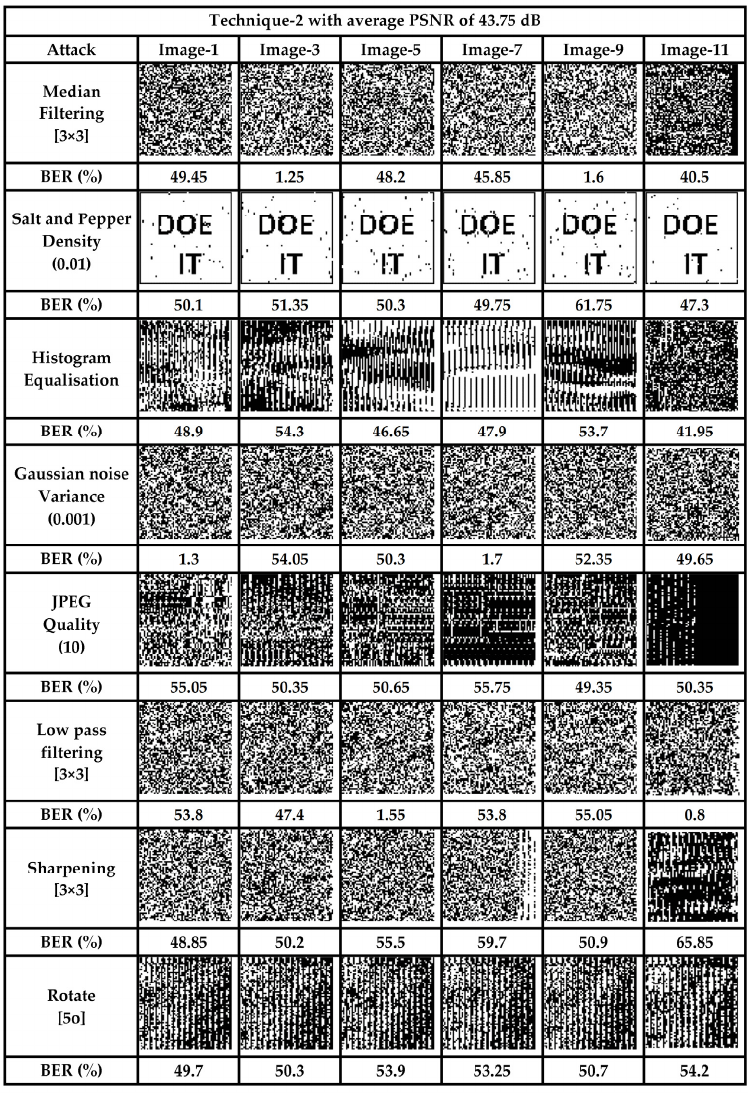
Figure 8. Authentication and fragility analysis (Technique-2). Table 5. Authentication analysis for salt and pepper and median filtering